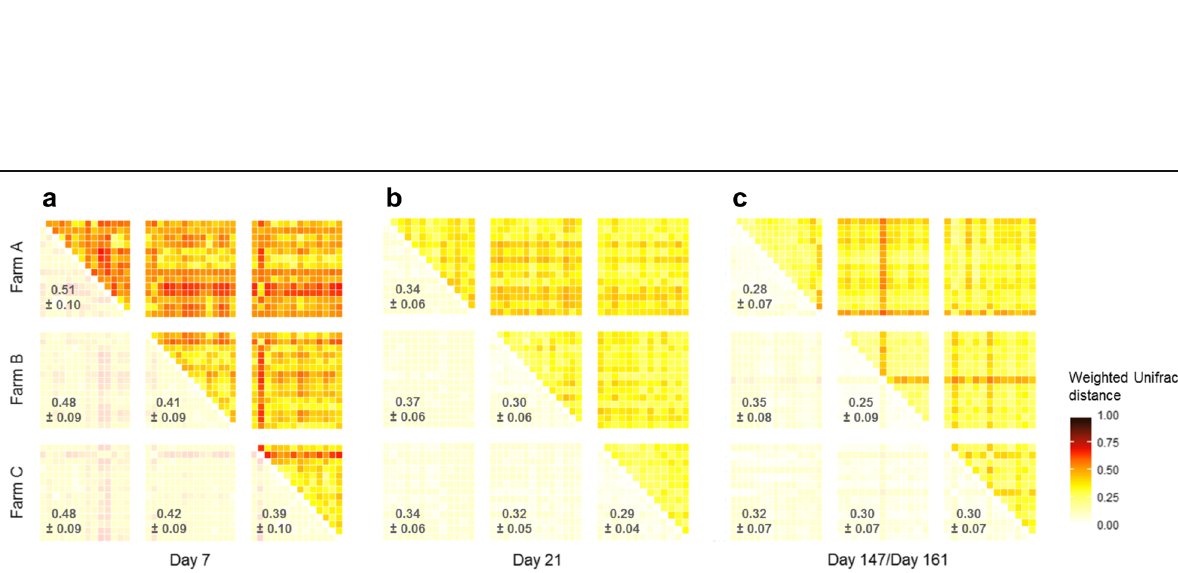
Fig. 2 Heatmaps of the weighted Unifrac distances at the first month and last month of fattening. Heatmaps of the β -diversity weighted Unifrac distances matrix are shown for the ( a ) first sampling (day 7), ( b ) second sampling (day 21), and ( c ) last sampling (day 161 for farms A and B and day 147 for farm C). Each square represents a pairwise distance between two calves. The pale yellow squares indicate low Unifrac distances, whereas dark red squares indicate high Unifrac distances. The calves are ordered according to the farms in both the lines and columns. The calf ’ s distance from itself is represented by the white square on the main diagonal. The means ± standard deviations for each sampling and farm are shown in the lower